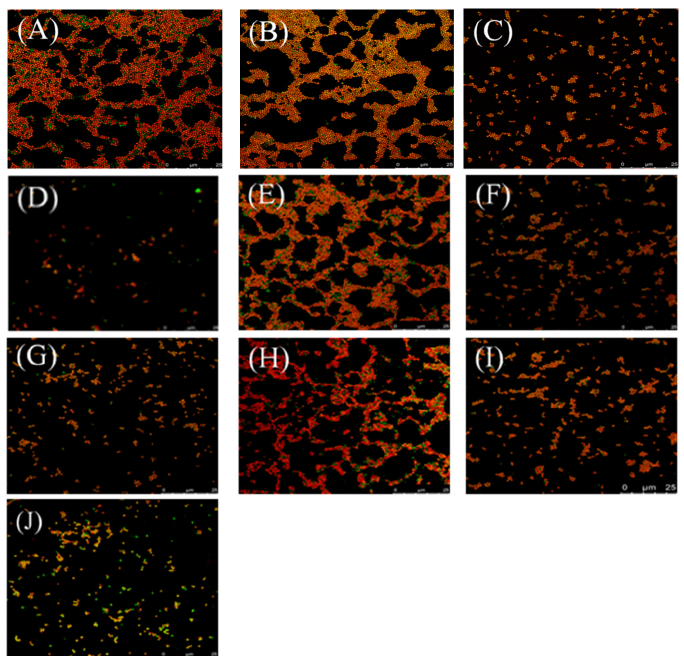
Figure 3. Effect of treating preformed biofilms of MRSA 3390 with cyclic peptide-1, 11, 14 at various concentrations for 24 h. The cyclic peptide-1, 11, 14 were present at 1 × MIC ( B , E , H ), 5 × MIC ( C , F , I ) and 10 × MIC ( D , G , J ) concentrations, respectively. ( A ) Controls with no cyclic peptide added. Biofilm bacteria were stained with SYTO 9 (green: live) and PI (red: dead). Bar = 25 μ m.